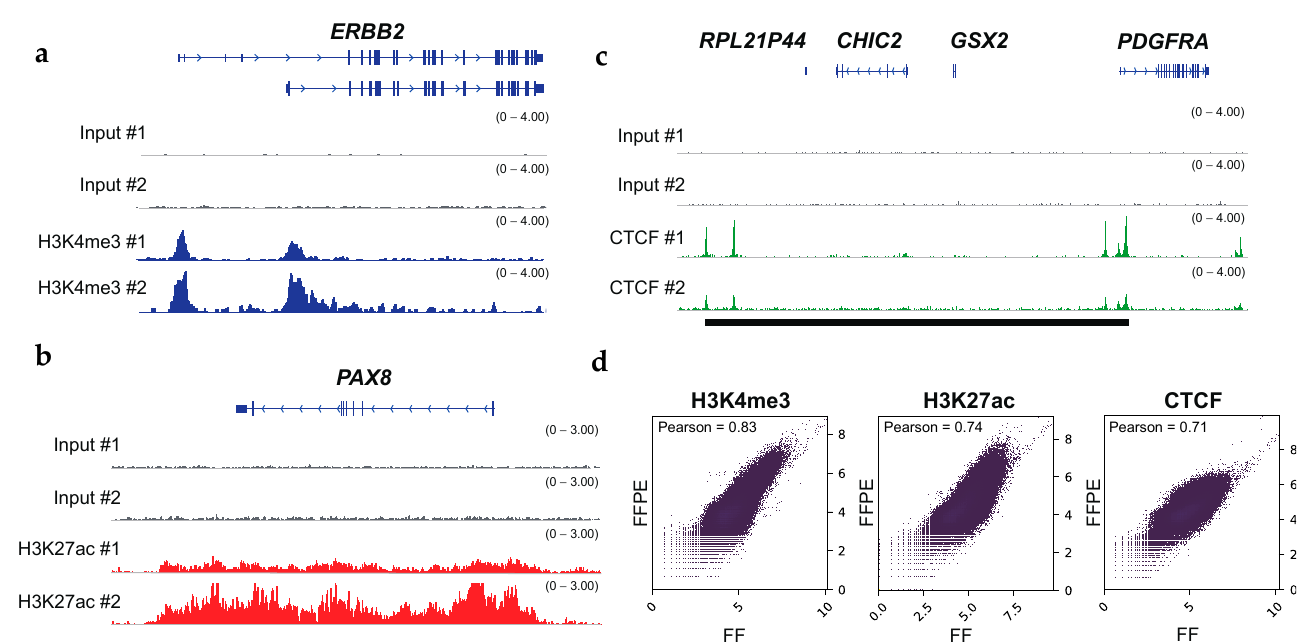
Figure 2. FFPE ChIP-seq with clinical specimens obtains the histone modification status of oncogenes and the binding status of the transcription factor CTCF. ( a ) IGV tracks (blue) of H3K4me3 peaks at ERBB2 locus, illustrating alternative promoter activities of oncogenes in OCCCs. ( b ) IGV tracks (red) of H3K27ac peaks at PAX8 locus, illustrating broad enhancer regions at oncogenes. ( c ) IGV tracks (green) of CTCF peaks at PDGFRA locus. Putative insulated neighborhoods are shown in black bars. Input controls are shown as gray. ( d ) Scatter plots showing the correlation between ChIP-seq datasets with FFPE and the matched FF in OCCCs. The read coverages for entire genomic regions (bin sizes: 10-kb) were utilized. The results for H3K4me3 (left), H3K27ac (middle), and CTCF (right) are shown. Pearson correlation coefficients are shown on the upper left.